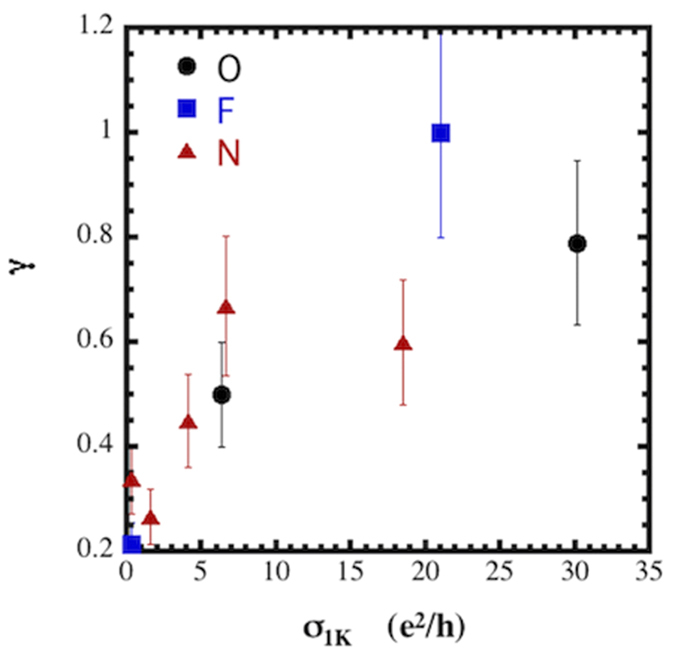
The ratio γ = (ΔRHall/RHall)/(ΔR/R) at 1.75 K as a function of σ1K, a measure of the distance to the exponentially localized state.